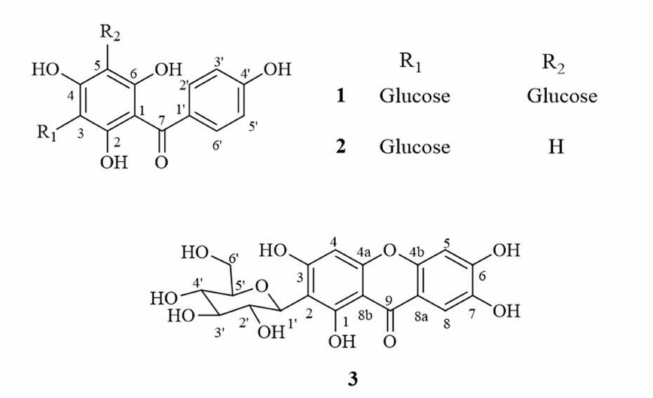
Figure 1. Chemical structure of compounds 1 (iriflophenone 3,5- C - β - d -diglucoside), 2 (iriflophenone 3- C - β - d -glucoside) and 3